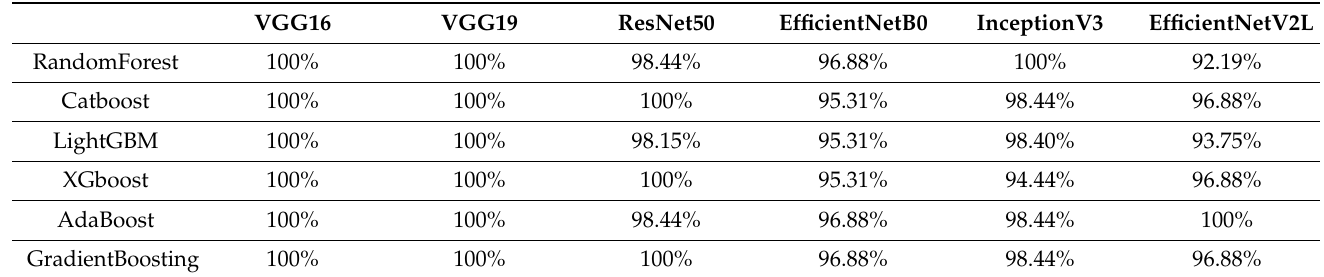
Table A8. Accuracy of each model combination for green squares.